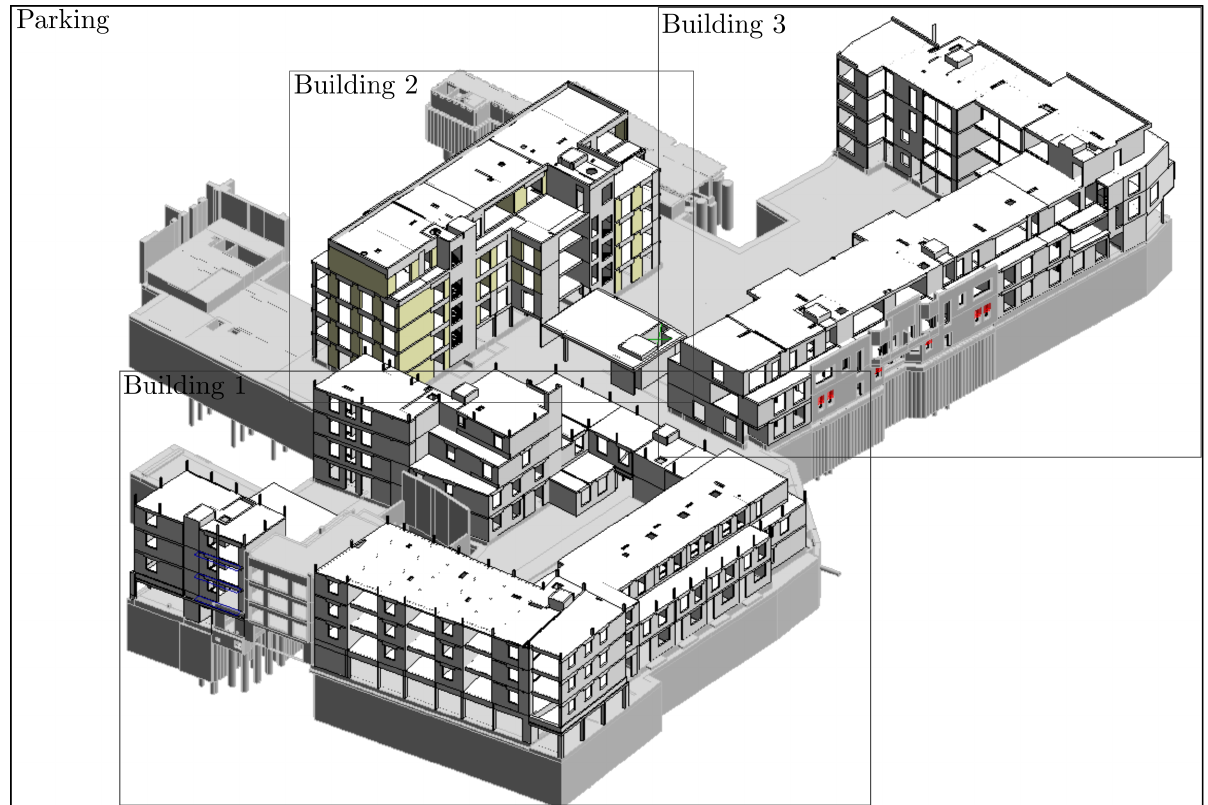
Figure 3: Overview of the BIM construction site consisting of 4 linked Revit